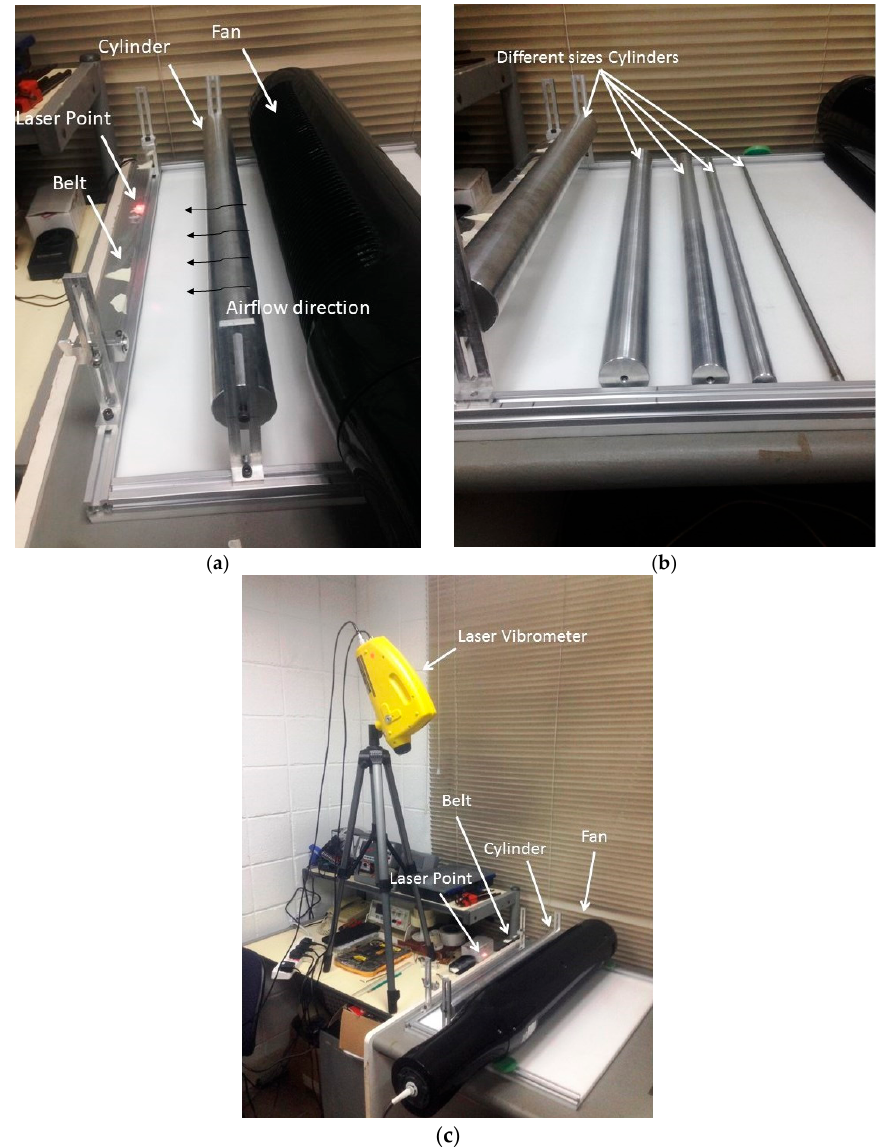
Figure 5. ( a ) Measurement point at the center of the belt and airflow direction. ( b ) Different sizes of cylinders. ( c ) Laser Vibrometer. cylinders. ( c ) Laser